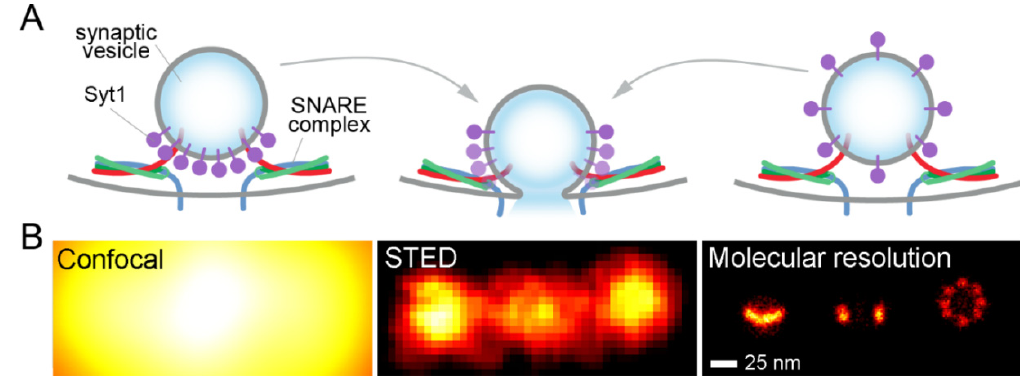
Figure 3. A fundamental di ff erence between super-resolution and molecular-scale resolution. ( A ), A cartoon description of synaptic exocytosis. This process is driven by SNARE proteins under the control of the Ca 2 + sensor synaptotagmin-1 (Syt1, purple). Syt1 has been suggested to form a ring next to the plasma membrane (left), which prevents fusion in the absence of Ca 2 + [57]. Alternatively, it may be distributed along the vesicle membrane (right). ( B ), We modeled the 2D Syt1 images in ( A ) using realistic parameters for confocal (left), STED (middle) or molecular-scale resolution (right). The di ff erent hypotheses can only be tested by molecular-scale